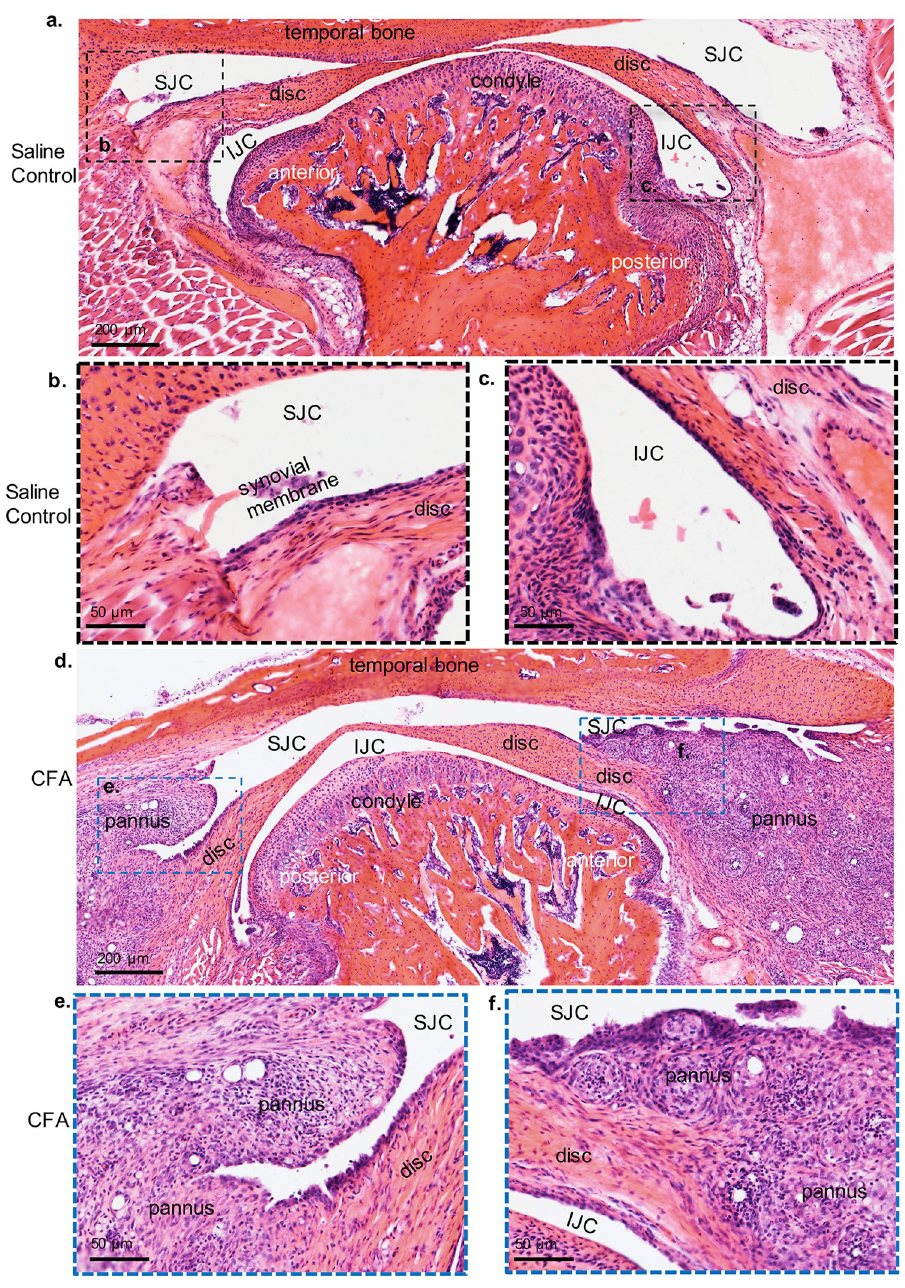
Fig 7. TMJ intra-articular injections of CFA promotes pannus formation on surrounding TMJ tissues. H&E Sections from TMJs treated with saline control ( a-c ) and contralateral TMJ treated with CFA ( d-f ). Black dashed box ( a ) is shown in higher magnification below (b,c). Blue dashed box ( d ) is shown in high magnification below ( e , f ). SJC = superior joint cavity; IJC = inferior joint cavity. TMJs treated with CFA showed arthritis phenotype, including pannus formation and synovitis within soft tissues surrounding